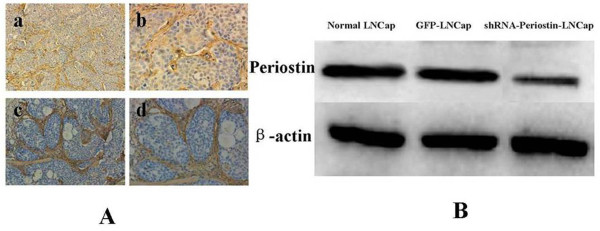
The expression of Periostin in the xenografts. A: The tissues of 12 xenografts from the groups of normal LNCap cells and control GFP-LNCap cells expressed strong positive Periostin in the stroma and tumor cells (a ×100, b ×200). But, the tissues of 6 xenografts from the group of down-regulated Periostin LNCap cells showed strong positive Periostin expression in the stroma and weak positive Periostin expression in tumor cells(c ×100, d ×200). B: The expression level of Periostin in the xenografts from the group of down-regulated Periostin LNCap cells significantly decreased compared to the xenografts from the other two groups.